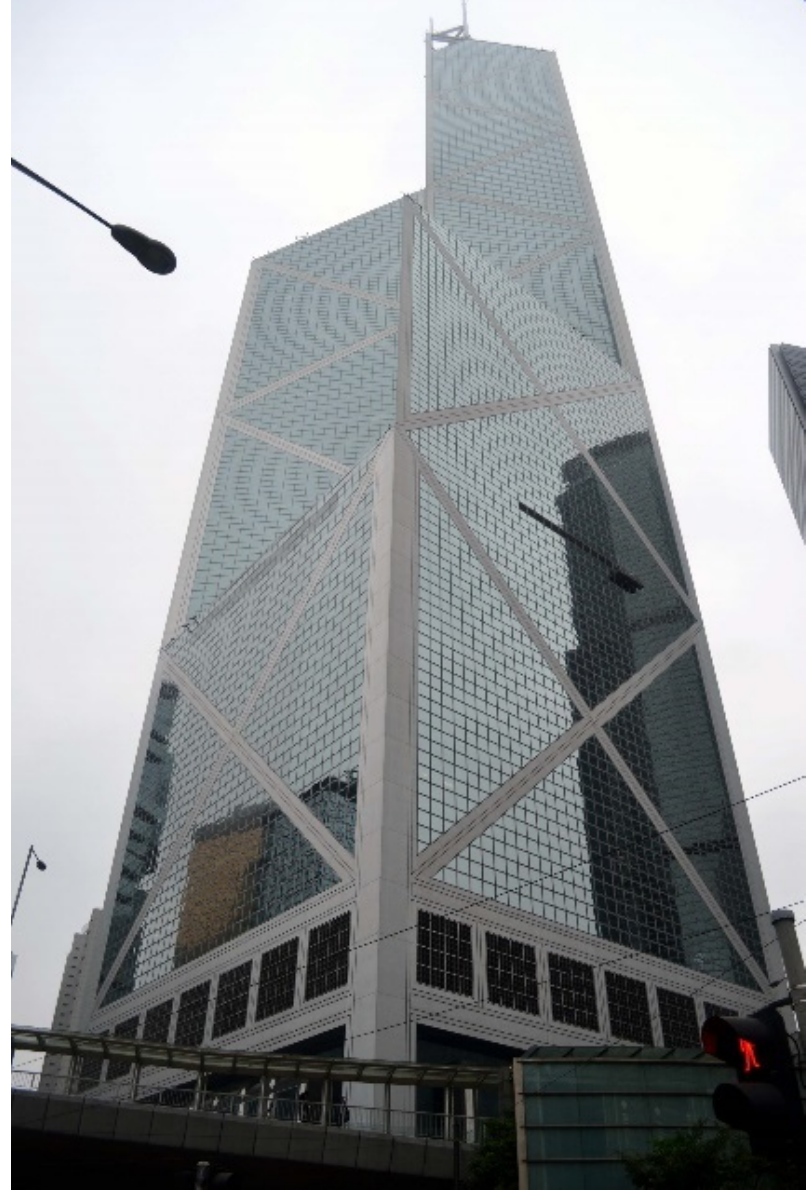
Figure 20. Bank of China Tower (1990) in Hong Kong by IMP. (Photo by K. Al-Kodmany). Importantly, articulation and structural details make a difference. For example, the Indigo Icon Tower in Dubai, UAE, uses an A shape that contains a prominent bracing system that adds a landmark quality to the building (Figure 21). NEO Bankside Complex utilizes unique details (e.g., hinges, pins, HSS members with triangular plate “fins,” clevis connectors) that lead to unique visual expression characterized by eloquence and